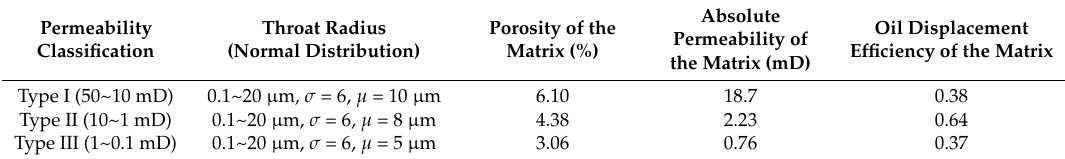
Table 2. Network parameters of different types.